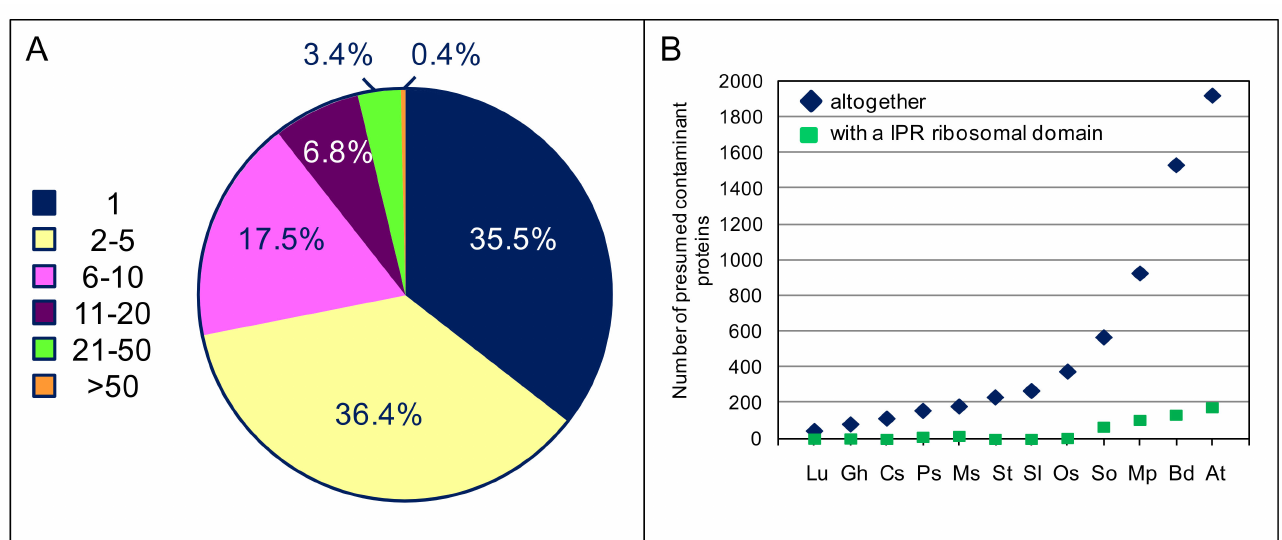
Figure 5. Overview of the distribution of Pfam domains in the presumed contaminant proteins of the 12 studied cell wall proteomes. ( A ) This pie chart represents the percentage of IPR domains shared by a given number of presumed contaminant proteins in the overall population of 6423 presumed contaminant proteins (from 1 to more than 50). Note that a given protein can contain several domains. For example, 559 Pfam domains (35.5%) are only present in one protein, whereas 6 domains (0.4%) are shared by more than 50 proteins. ( B ) This graph represents the total number of presumed contaminant proteins in each of the cell wall proteomes present in WallProtDB-2 (dark blue diamonds) and the number of proteins exhibiting a ribosomal domain (green squares). See Appendix A. for